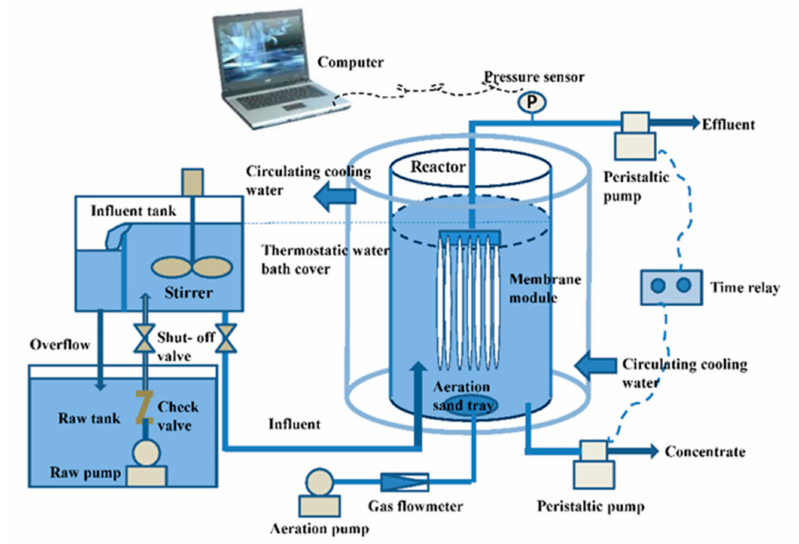
Figure 1. Schematic of the experimental